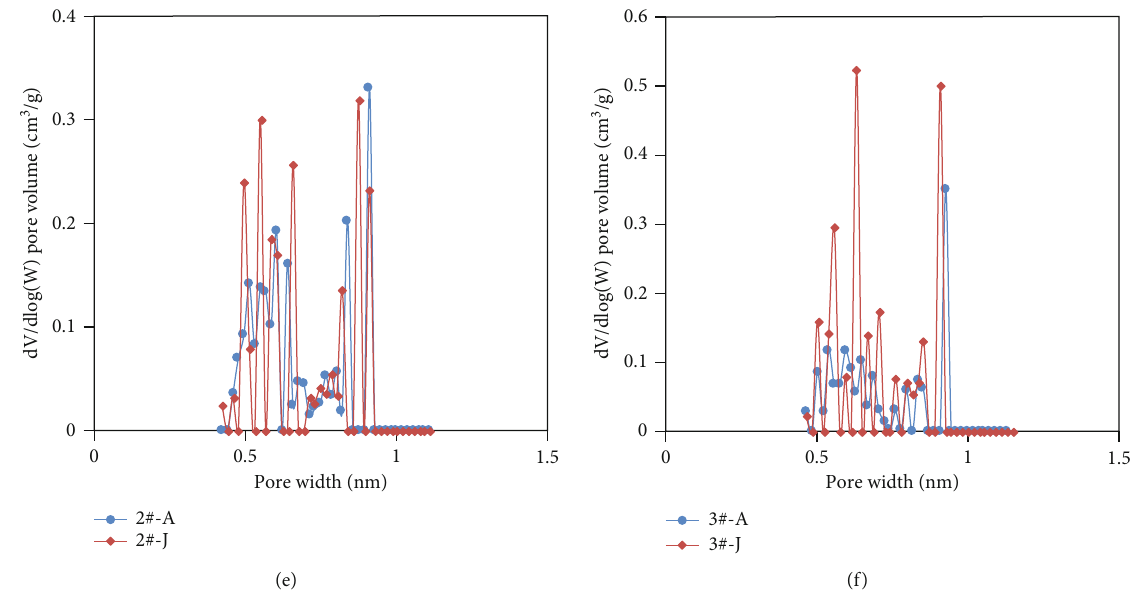
Figure 7: PSD is calculated according to the CO